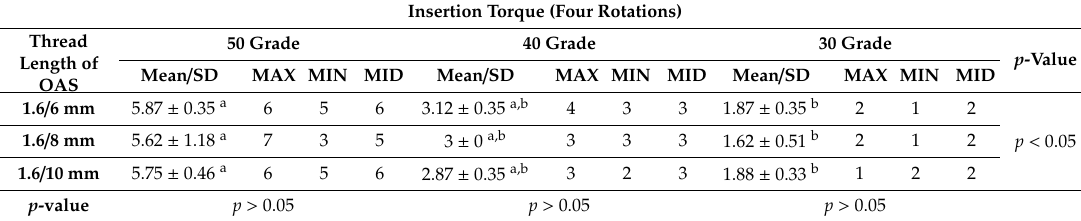
Table 1. Insertion torque values (four rotations) measured using the automatic anchorage method.